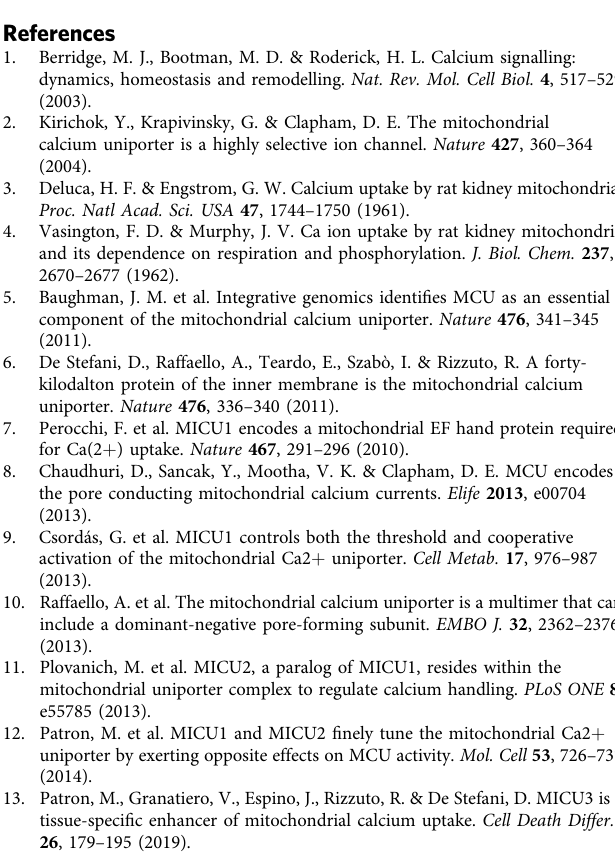
Fig. 12. All genomic data sources and versions analyzed in the study and the raw phylogenetic trees in newick format are provided in Supplementary Data 2. The silhouette images used in Figs. 3 and 5 were downloaded from PhyloPic (http://phylopic. org/) or wikipedia (https://www.wikipedia.org/), or designed by the A.P. in Inkscape